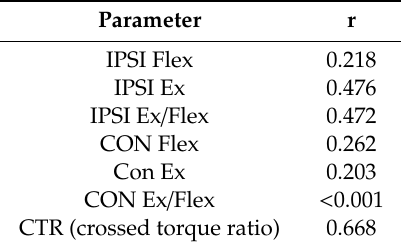
Table 3. Correlations (Pearson’s r) between the torque parameters and the pelvic torsion angle.